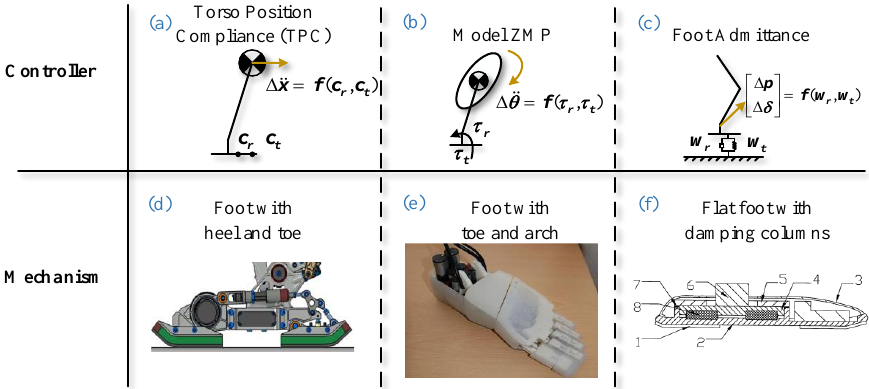
Figure 1. Different strategies for improving